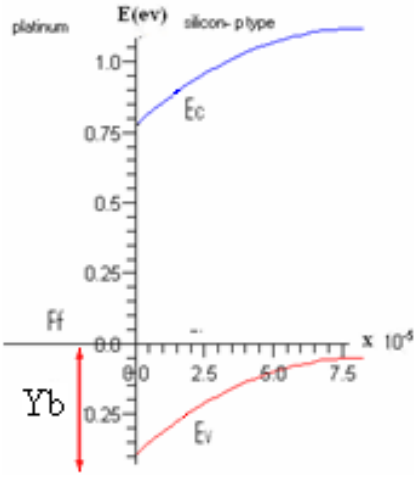
Figure 2. Energy band diagram in platinum—silicon p-type contact. Ef is Fermi surface in metal—semiconductor junction, Ec is conduction band, Ev is valance band, Yb is potential barrier in platinum-silicon contact (Y-axis ) and X-axis is